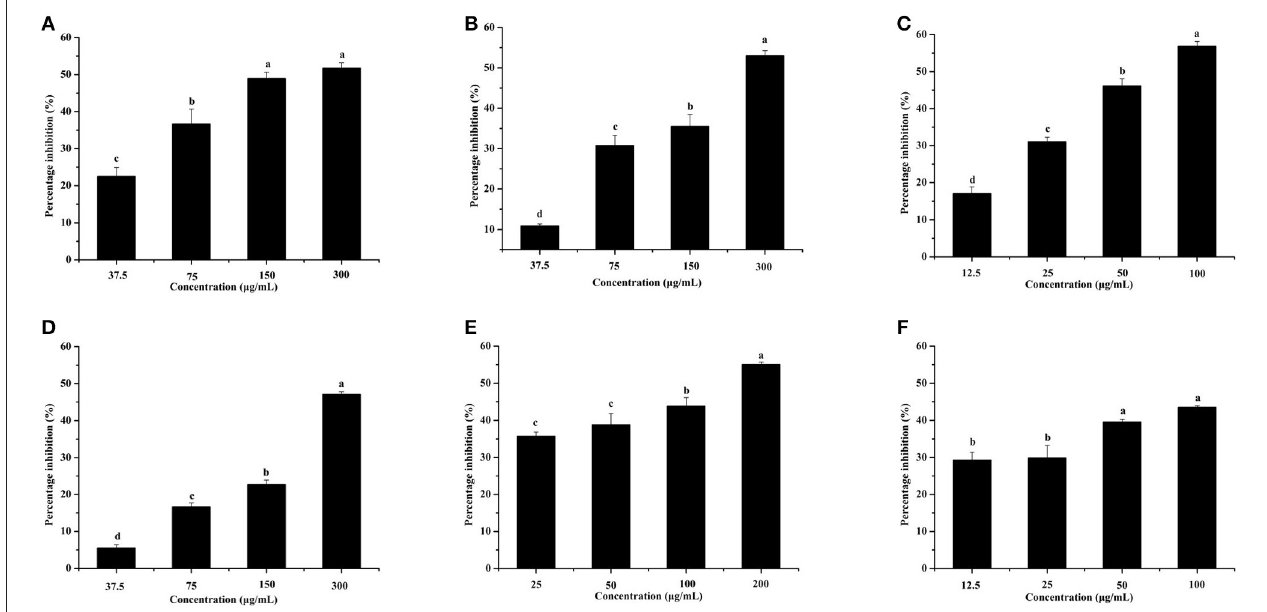
FIGURE 8 | Effects of the six identified compounds on pyocyanin production. Gallic acid (A) , Catechin (B) , Ellagic acid (C) , Chlorogenic acid (D) , Quercetin (E) , and Kaempferol (F) . Means with different small letters (a–d) are significantly different ( p < 0.05).